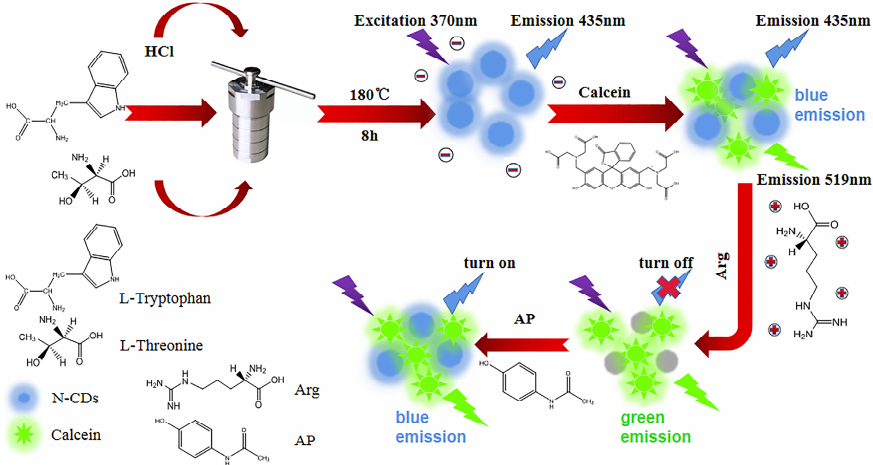
Figure 1. Schematic diagram of the construction of N-CD/calcein fluorescent sensor and its “on–off–on” mode for Arg and AP detection.